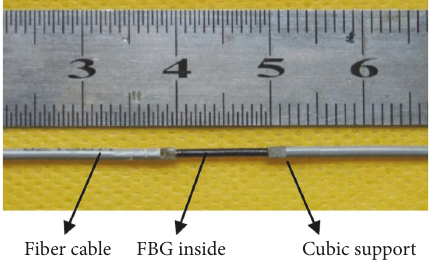
Figure 4: Photo of the packaged FBG